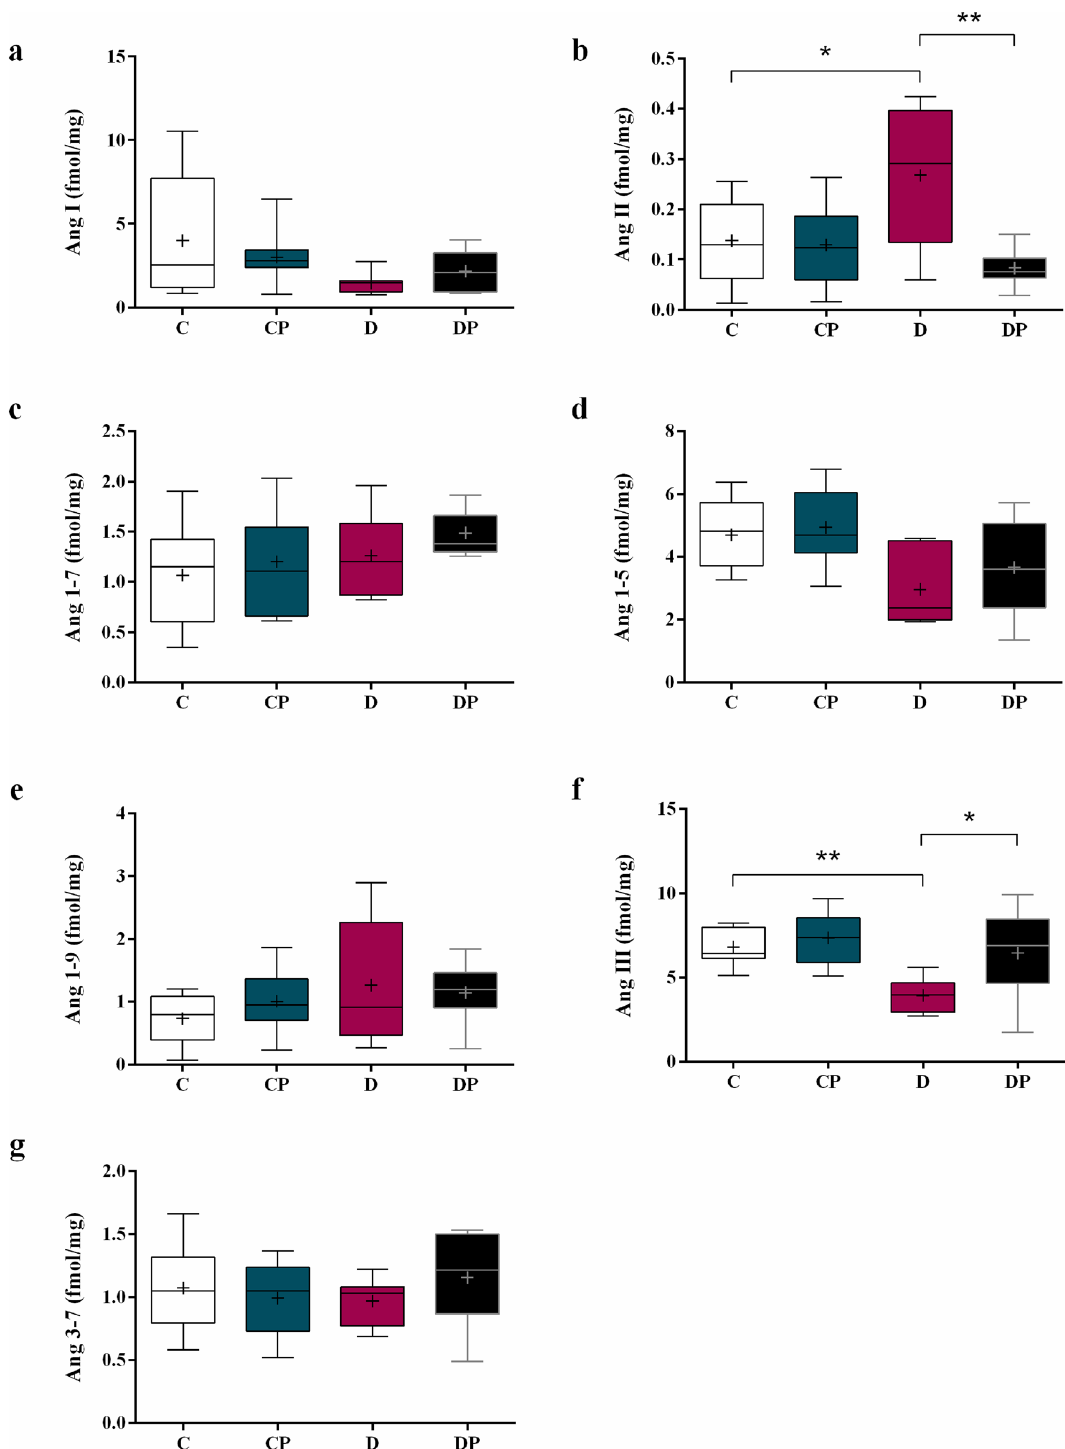
Figure 9. Liver concentration of (a) Ang I, (b) Ang II, (c) Ang (1–7), (d) Ang (1–5) (e) Ang (1–9), (f) Ang III and (g) Ang (3–7) in control (C), control + probiotic (CP), diabetic (D) and diabetic + probiotic (DP) groups (n = 6–9/group). Data are from C57BL/6 STZ-induced diabetic mice, + /- Saccharomyces boulardii (0.5 × 10 8 colony-forming units, THT 500101 strain , Probiotics and Starters Cultures, Belgium) for 8 weeks. A horizontal line inside the box indicates the median value of the samples within each group, and the upper and lower edges of the box indicate the quartiles. The significance was determined by Two-way ANOVA followed by Tukey’s test for multiple comparisons of means (GraphPad Prism 6). + indicates mean value. *p ≤ 0.05, **p ≤